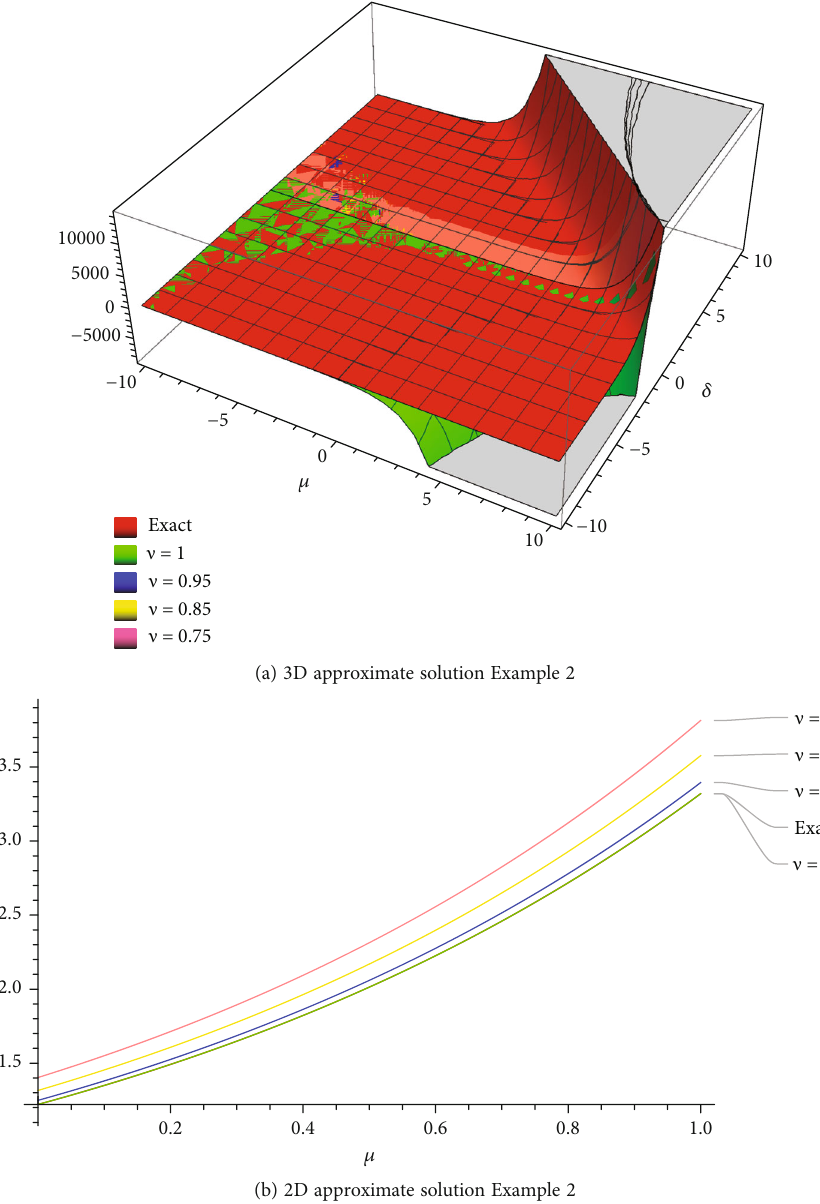
Figure 2: Create 2D and 3D comparison charts of precise data and predicted computational outputs for Example 2, using δ = 0 : 2